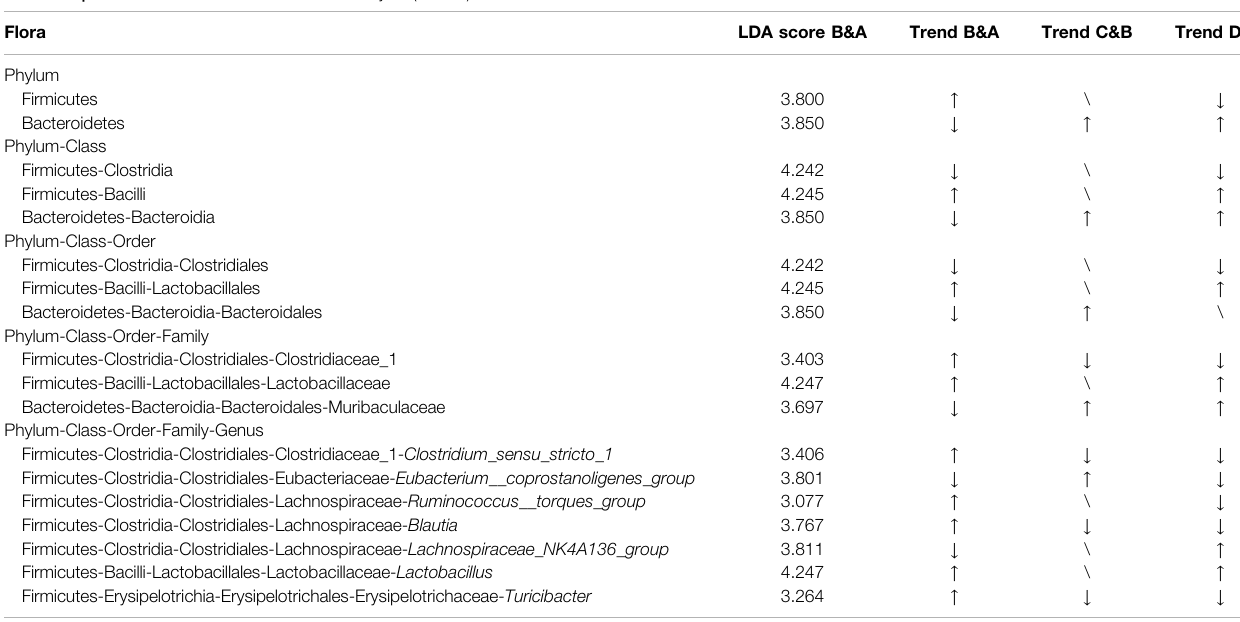
TABLE 1 | Results of identi fi cation micro fl ora analysis ( n (cid:1) 10). Flora Phylum Firmicutes Bacteroidetes Phylum-Class Firmicutes-Clostridia